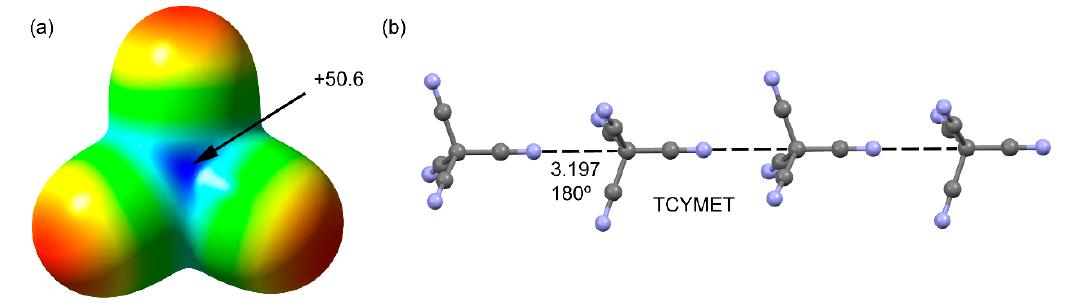
Figure 6. ( a ) MEP surface of tetracyanomethane at the B3LYP / 6-311 + G* level of theory. Isosurface 0.001 a.u.; ( b ) X-ray structure of CSD refcodes TCYMET. Distance in Å.